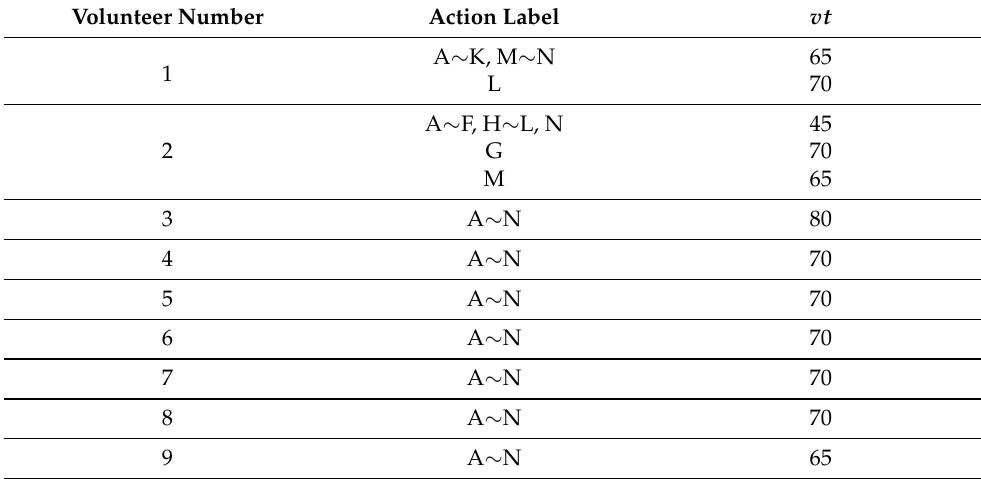
Table 2. Parameter vt of action.